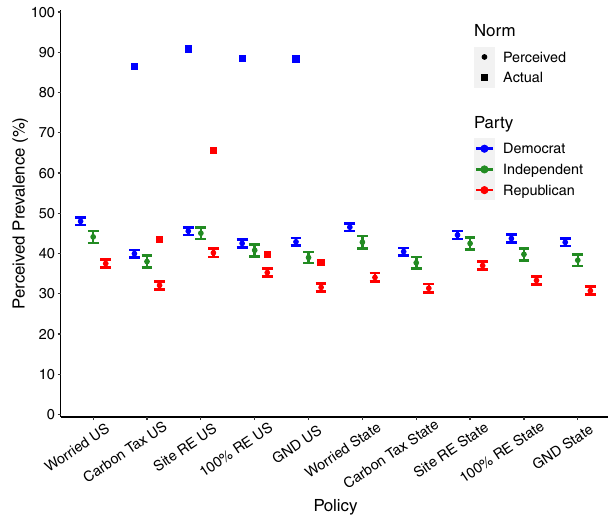
Fig. 2 | Partisan perceptions of popular climate worry and support for climate policy at national and state levels. All judgments were elicited for everyone in eithertheentirenationorone ’ sstate(notonlyforone ’ sfellowpartisans).Itemson the left labeled with “ US ” indicate estimates of support for policies at the national level,whilethoseontherightlabeledwith “ State ” indicateestimatesofsupportfor those in participants ’ own state. Actual partisan support levels available from contemporaneouspolling(availableforfourUSpolicies 12 )areindicatedbysquares. Error bars represent 95% con fi dence intervals for the norm perception means illustrated. RE refers to renewable energy. GND refers to the Green New Deal. N =6119 survey participants, including 2777 Democrats, 1022 Independents, and 2320